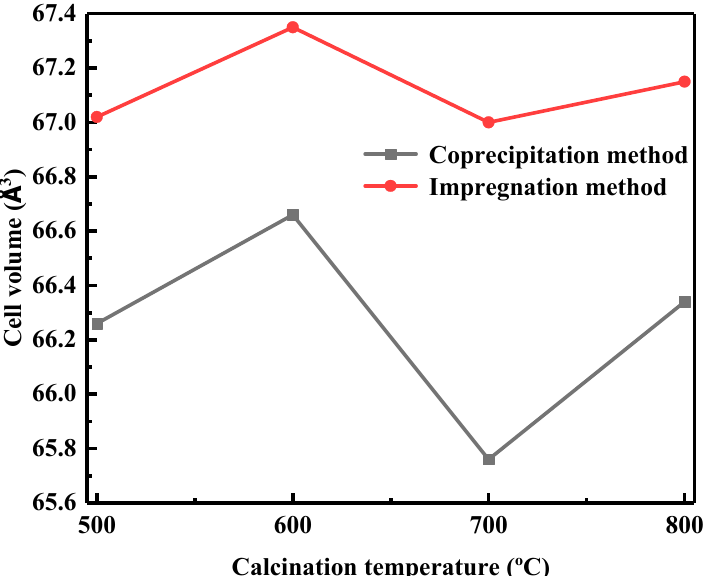
Figure 7. Lattice parameters of MgZr catalysts: coprecipitation method: 500 °C: a = b=3.60 Å, c = 5.12 Å ; 600 °C: a = b = 3.60 Å , c = 5.15 Å ; 700 °C: a = b = 3.59 Å , c = 5.11 Å ; 800 °C: a = b = 3.60 Å , c = 5.11 Å ; impregnation method: 500 °C: a = b = 3.59 Å , c = 5.20 Å ; 600 °C: a = b = 3.61 Å , c = 5.16 Å ; 700 °C: a = b = 3.59 Å , c = 5.20 Å ; 800 °C: a = b = 3.61 Å , c = 5.15 Å.